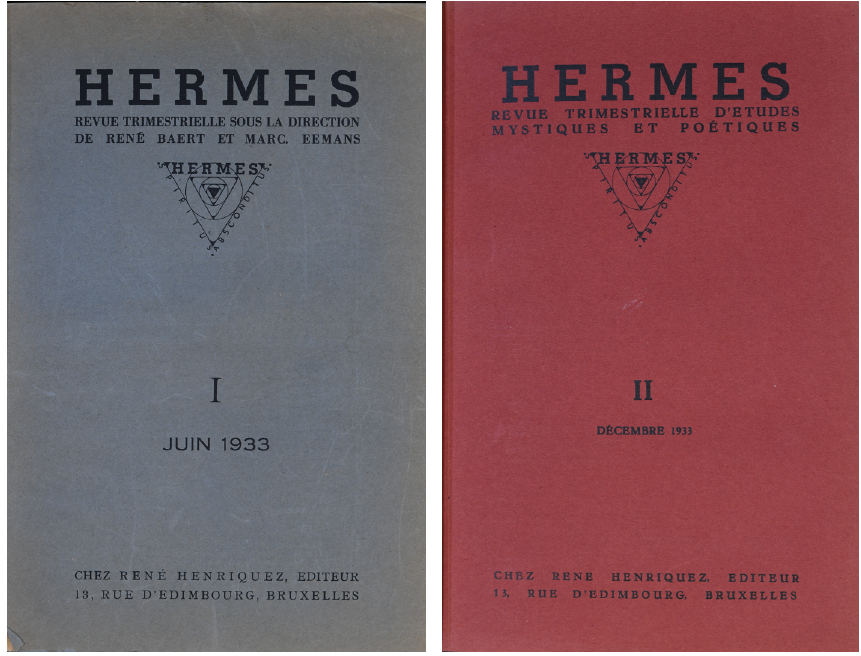
Fig. 1 Covers of the first two issues of Hermès , published in June 1933 and December 1933,